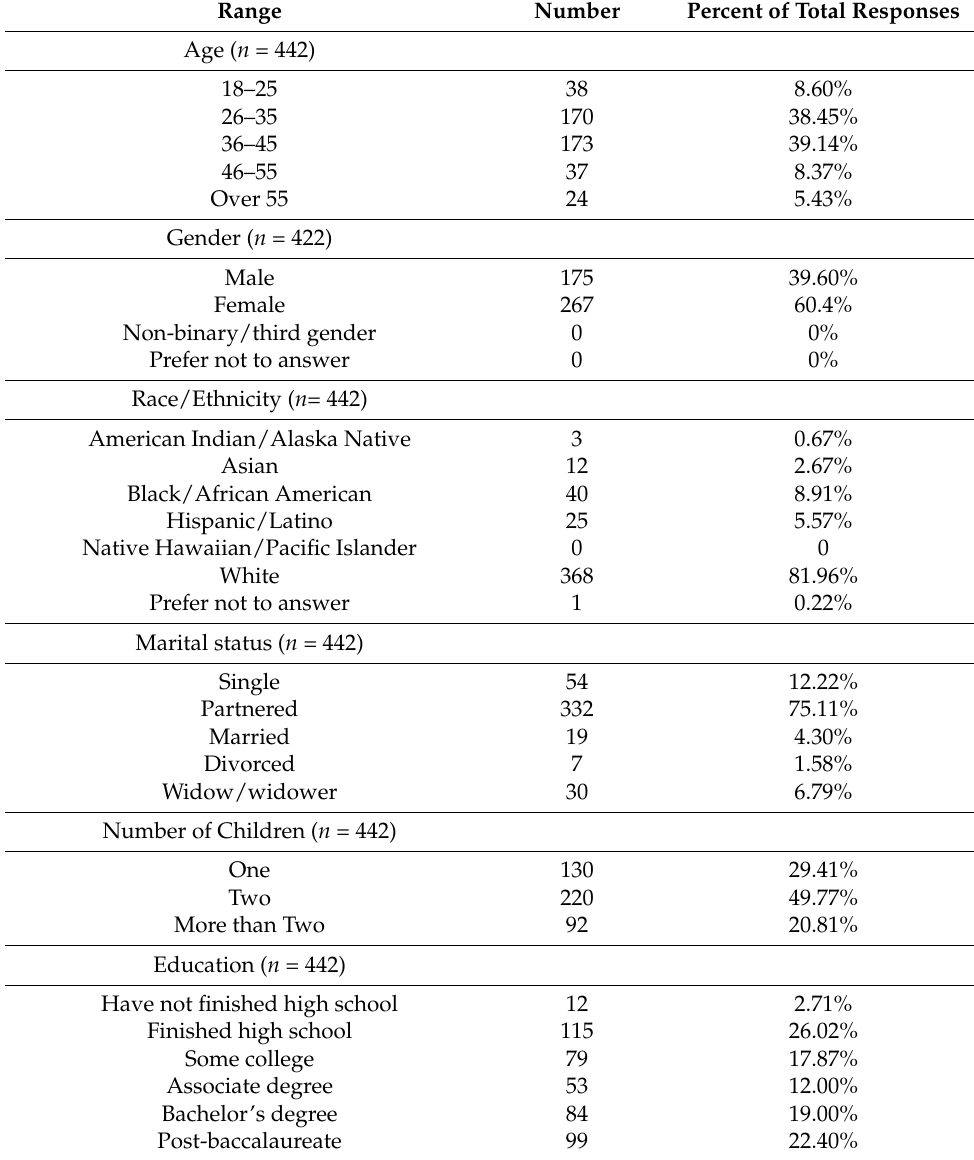
Table 1. Respondent